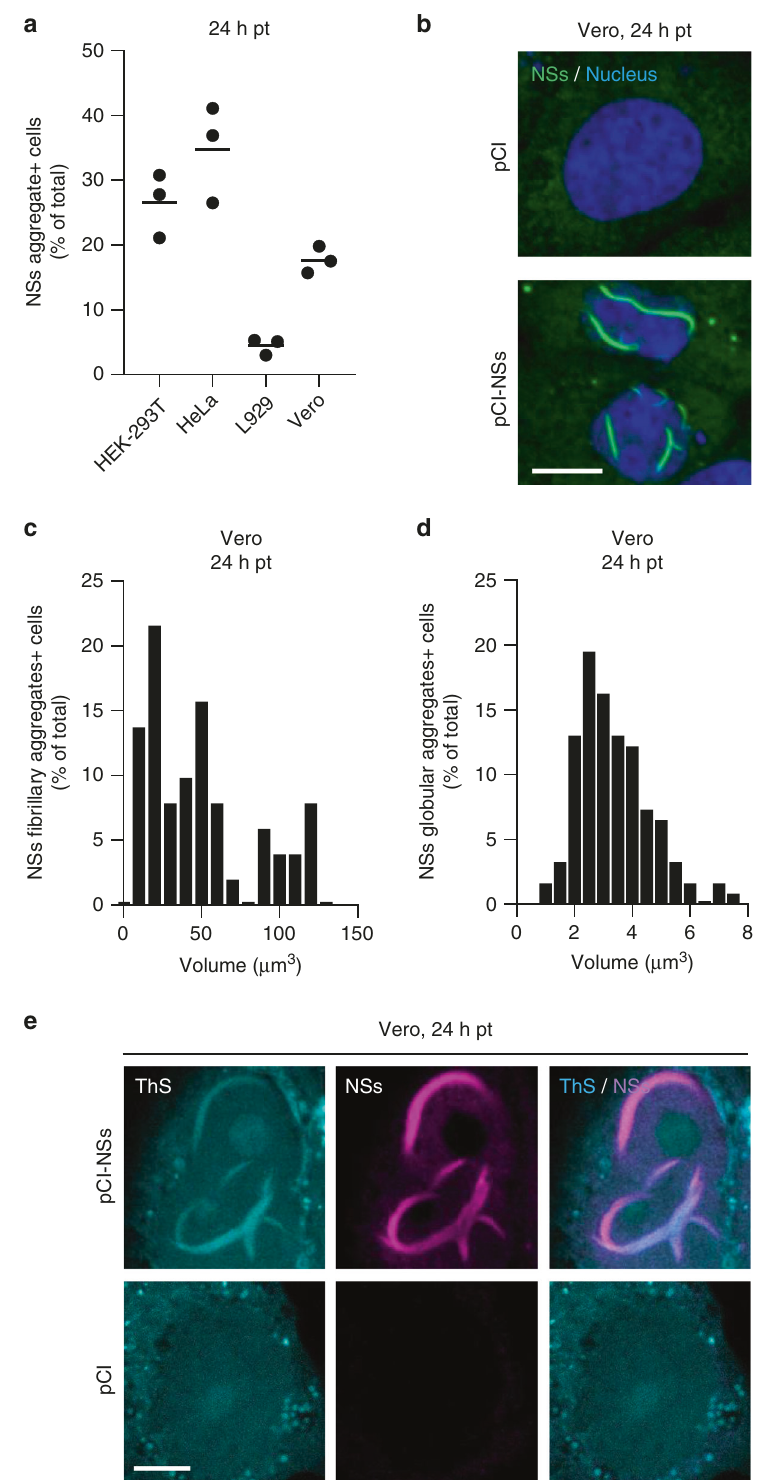
Fig. 7 NSs expressed from plasmid DNAs forms nuclear and cytosolic aggregates. a Various cell lines were transfected with the plasmid vector pCI encoding NSs. Cells were fi xed 24 h post-transfection (pt), immuno-stained against NSs, and imaged by fl uorescence microscopy. Images were analyzed for the percentage of total cells positive for NSs aggregates. Points represent independent experiments ( n = 3). Center line, mean. b shows confocal images of transfected Vero cells with nuclei in blue and NSs in green. Images are representative of three independent experiments. Scale bar, 10 µ m. c , d Transfected Vero cells were analyzed for the size distribution of NSs fi brillary ( c , n = 52) and globular ( d , n = 164) aggregates as described in Supplementary Fig. 2. e Transfected Vero cells were permeabilized with a Triton X-100-based buffer and then stained with the amyloid-binding dye ThS (blue) and Abs against NSs (purple) before confocal imaging. Experiments were repeated independently thrice with similar results. Scale bar, 5 µ